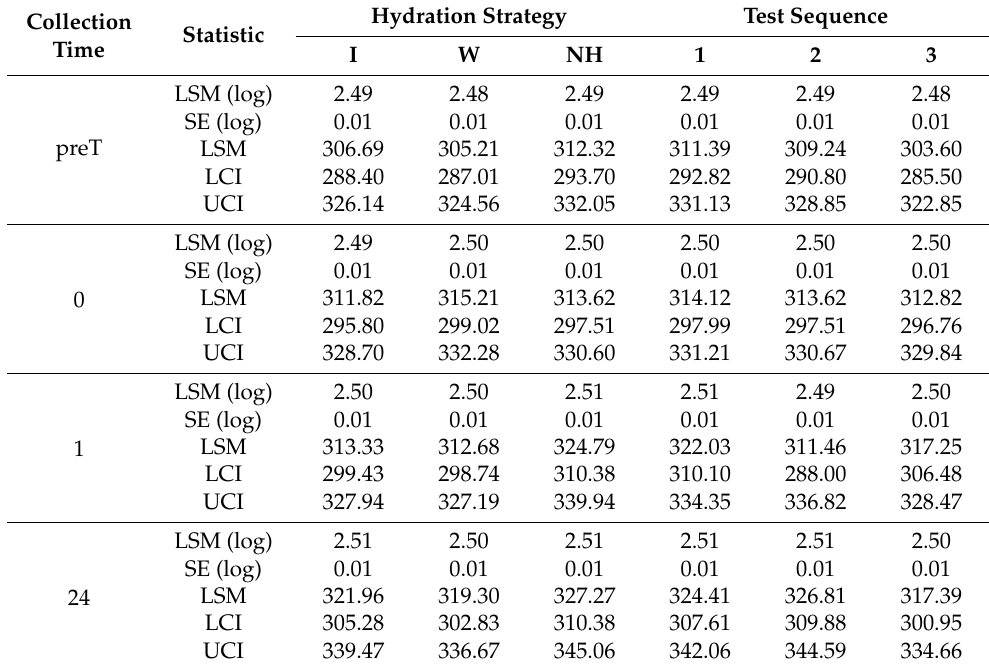
Table 7. Results of pro-oxidative and antioxidant status [ µ mol-L − 1] measured before the test (preT) and 0, 1, and 24 h after the test performed for different hydration strategies in three consecutive tests: marginal means (LSM); standard errors (SE) for values after logarithmic transformation (log); and marginal means and upper (UCI) and lower (LCI) confidence intervals restored to original